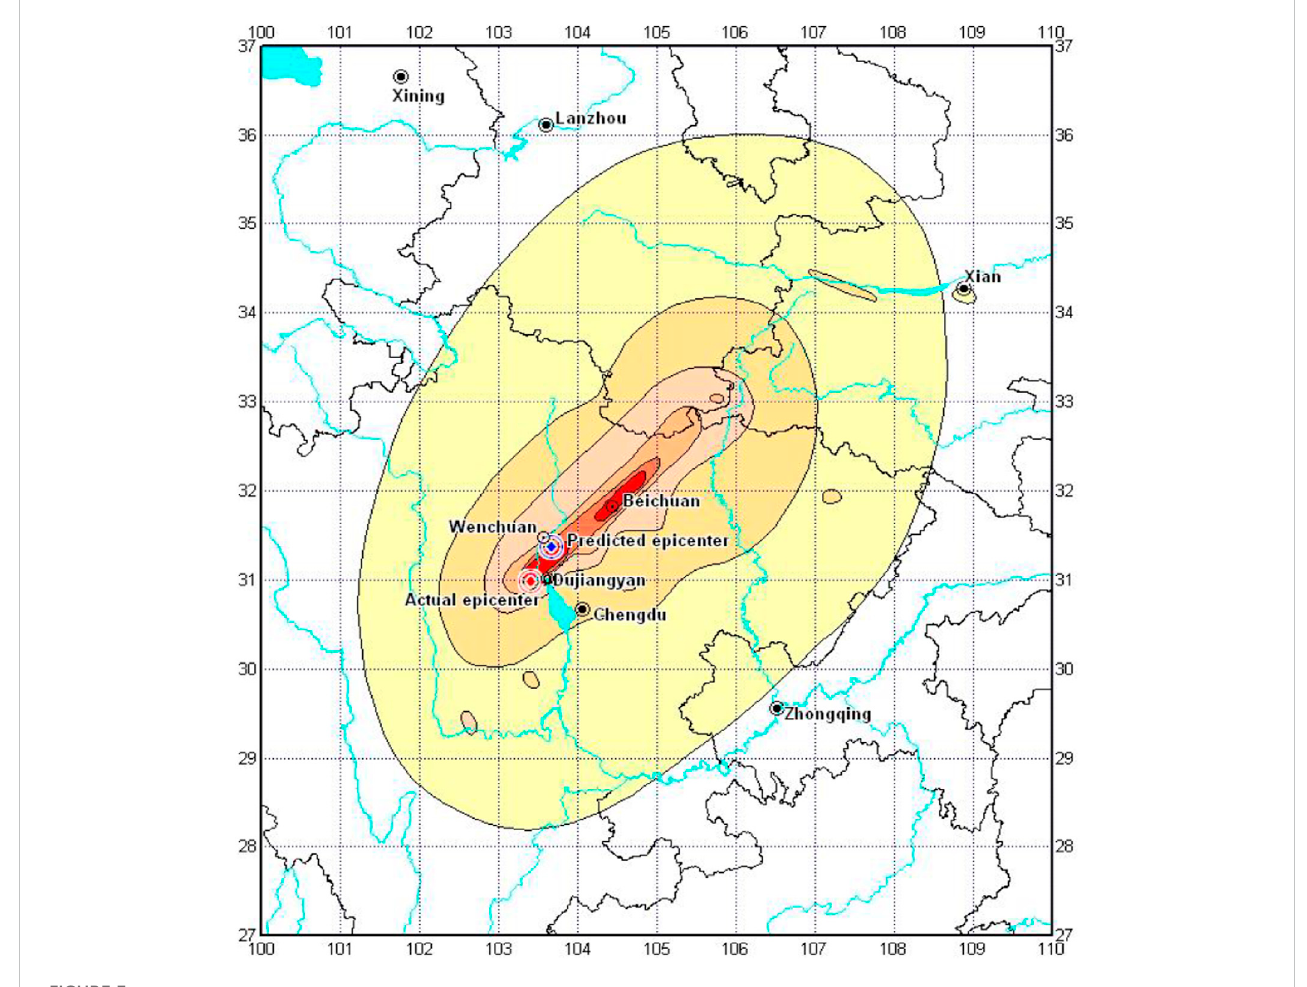
FIGURE 3 Predicted epicenter and earthquake intensity of the Wenchuan Ms 8.0